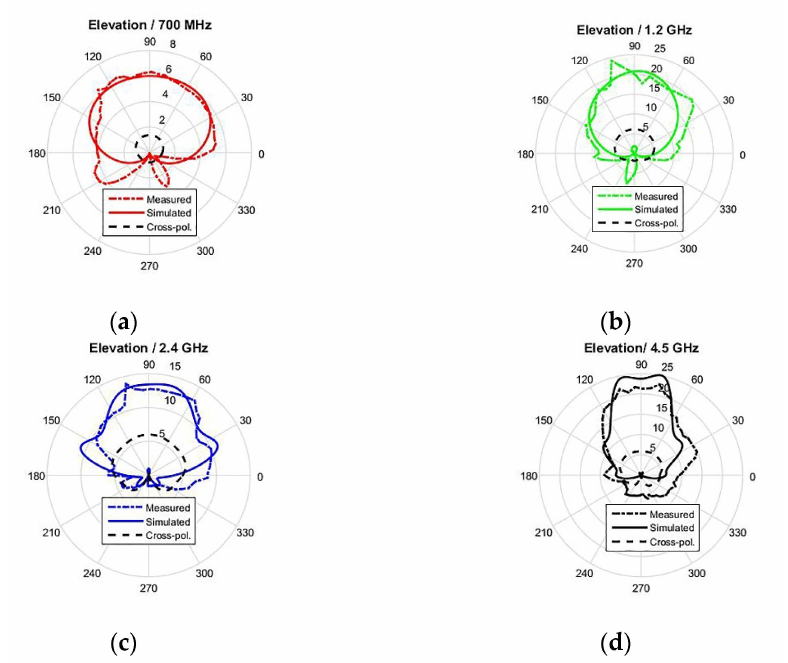
Figure 14. Radiation pattern setup for the proposed antenna inside EMC chamber.